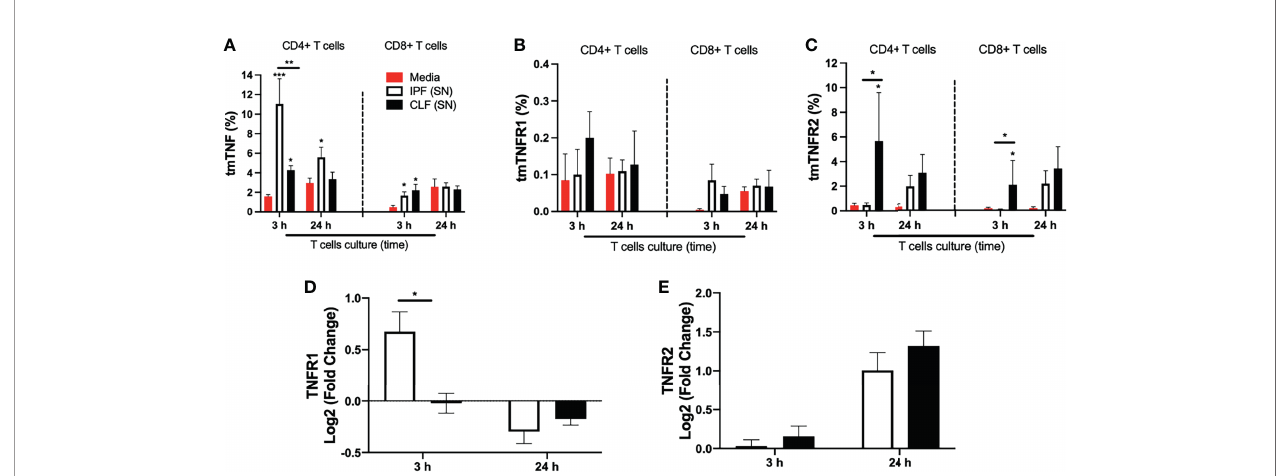
FIGURE 6 | The supernatant (SN) from IPF fi broblasts increases tmTNF expression and positively regulates TNFR1 at the transcriptional level in T cells at a short time of exposure. T cells obtained from fi ve different healthy donors stimulated with different IPF (SN) and CLF (SN) were recovered at the end of the culture, and cells were prepared for fl ow cytometry and for obtention of RNA to perform a quantitative real-time PCR. The percentages of CD4+ T cells (left) and CD8+ T cells (right) positive to transmembrane (tm) TNF (A) , tmTNFR1 (B) , and tmTNFR2 (C) were obtained by fl ow cytometry. To acquire the transcriptional level, we calculated the log2 fold change of TNFR1 (D) and TNFR2 (E) . Bars indicate mean ± SD from fi ve independent biological experiments. A multiple t -test and Holm – Sidak as post-test (A – C) or a Mann – Whitney U test (D, E) was used. * p < 0.05, ** p < 0.01, *** p <